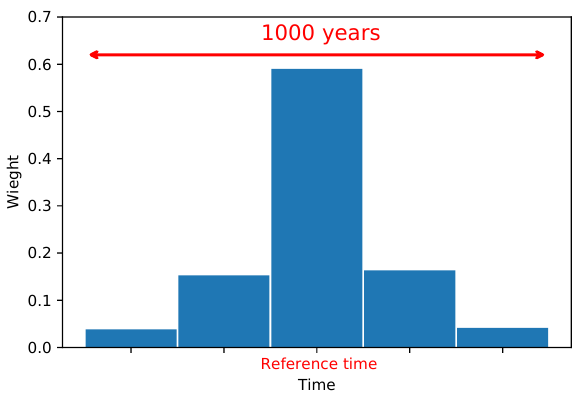
Figure 12. Schematic showing the weights for observations with respect to their distance to the target year. A time window of 1000 years is chosen. The observations are weighted depending on their distances to the reference time.